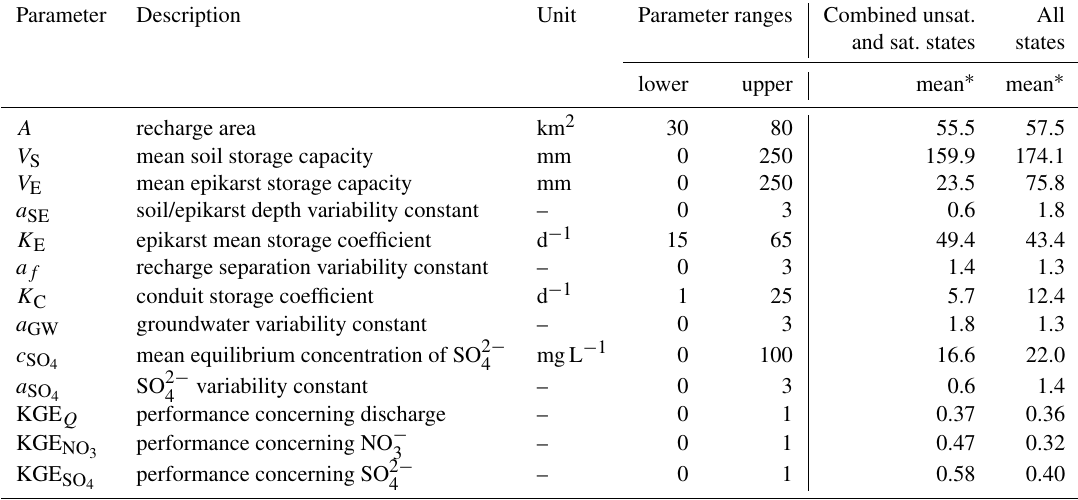
Table 2. Description of model parameters, ranges for parameters estimation and average values found for the combined unsaturated and saturated flow states, and the entire time period including the disinformative period of river influence. Parameter Description Unit Parameter ranges Combined unsat.